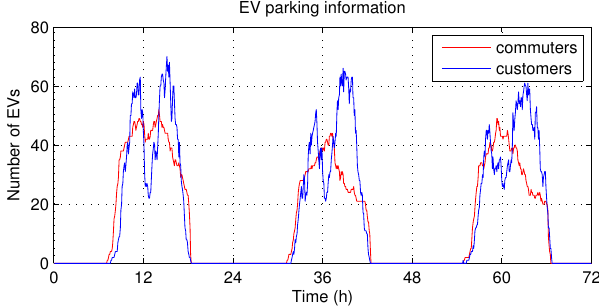
Figure 5. Vehicle parking records of district office in